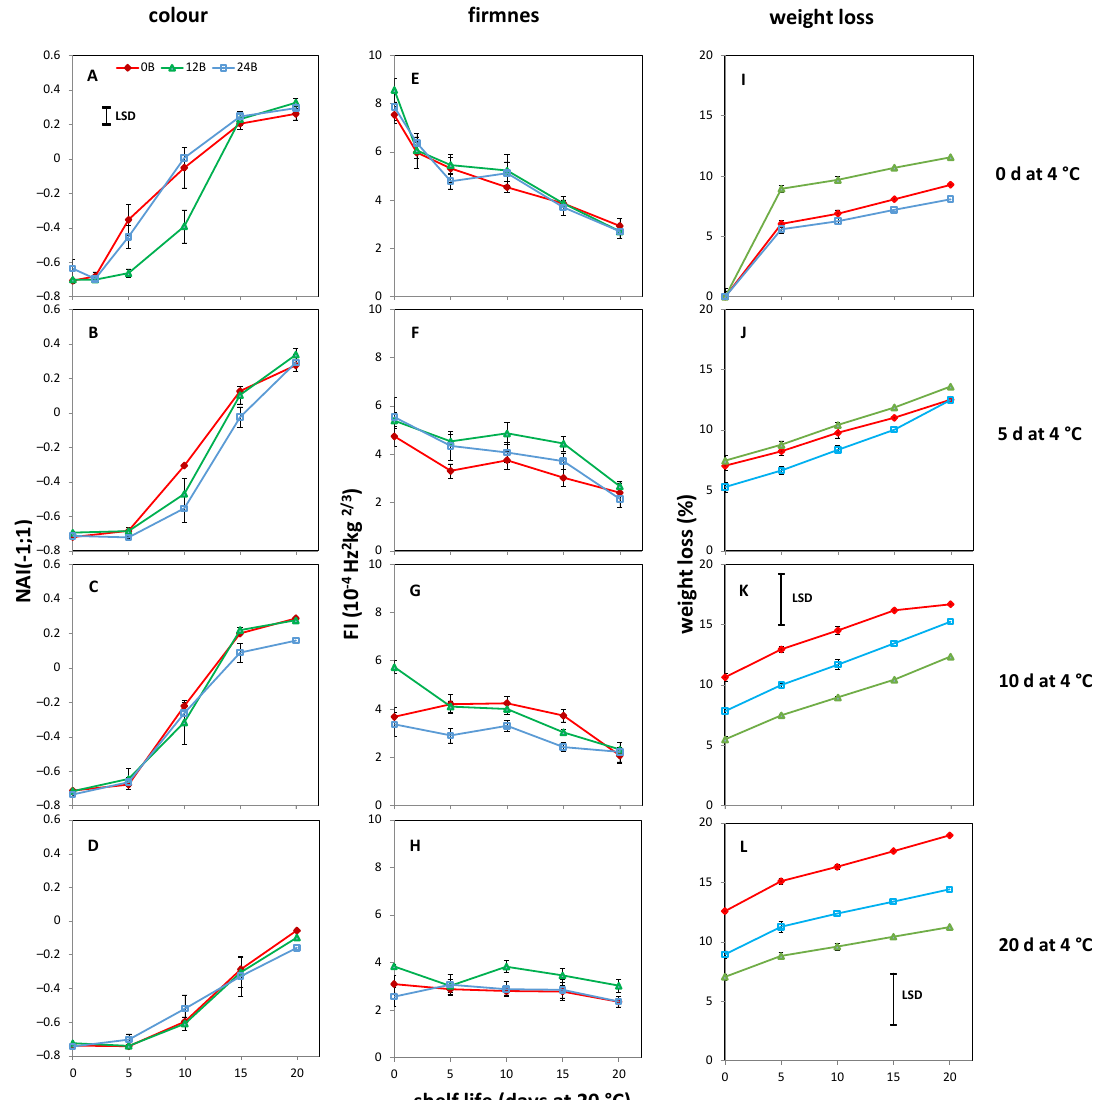
Figure 3. Average color, firmness and weight loss development of five MG tomatoes during shelf life at 20 °C after cold storage at 4 °C for 0 d ( A , E , I ) 5 d ( B , F , J ), 10 d ( C , G , K ) or 20 d ( D , H , L ) with indicated standard error, respectively. Colors indicate tomato cultivation with 0 (red symbols), 12 (green symbols) and 24% (blue symbols) additional blue light. LSD values, when present, are indicated per panel.